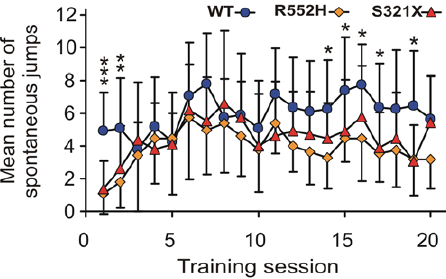
Figure 2. Logistic growth functions modeling the increase of the discrimination index d 9 as function of the training day. d 9 expresses the achieved average performance level of tone discrimina- tion of the animals in each experimental group (see Methods). Discrimination performance of the WTs increases rapidly and stays at a maximum level already from day 2 onwards. Discrimination performance of the R552H heterozygotes increases slowly but finally reaches the level of the WTs. Discrimination performance of the S321X heterozygotes increases very slowly and does not reach the levels of WTs and R552H heterozygotes. The correlation coefficients of the growth functions are statistically significant (p , 0.01 in each case).